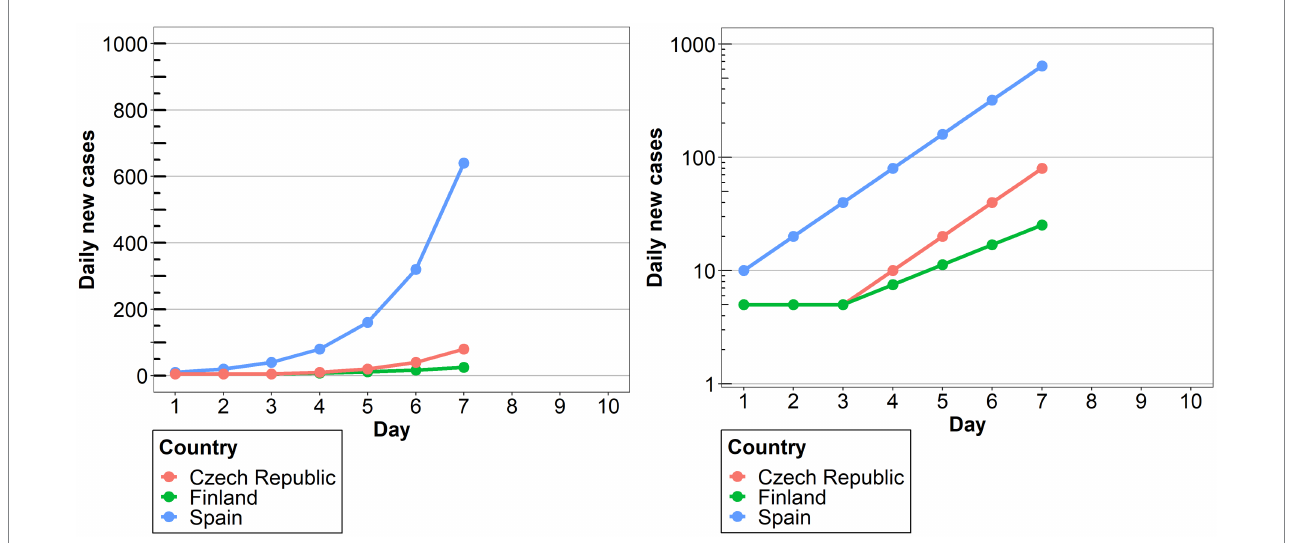
FIGURE 1 The two graphs presented to participants used in the linear and the log conditions,